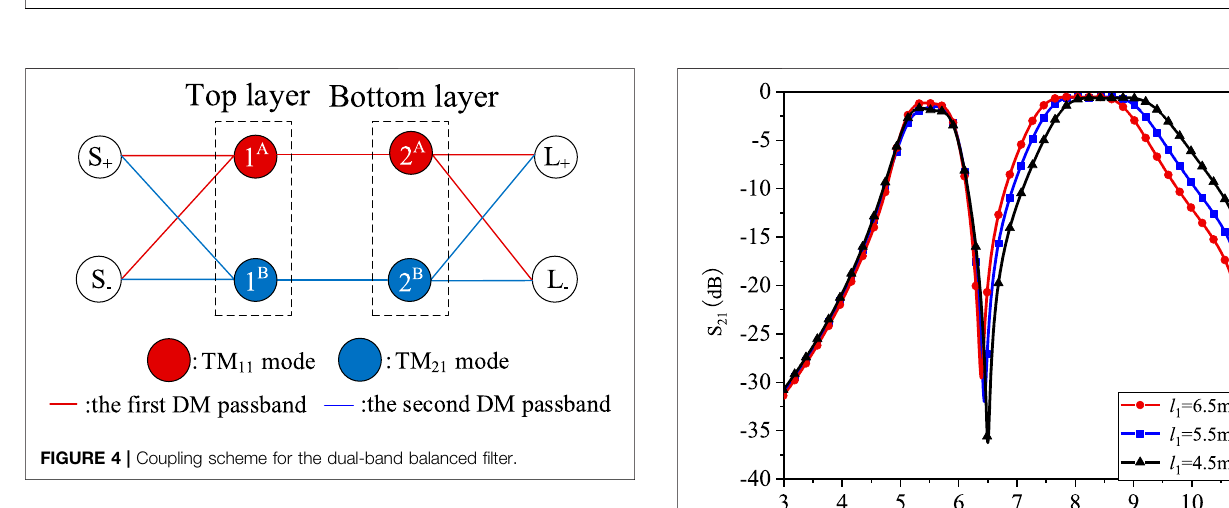
FIGURE 3 | Simulated H- fi elds of the resonant modes in the circular patch. (A) TM 11 mode (Mode 1), (B) TM 11 mode (Mode 2), and (C) TM 21 mode (Mode 3).